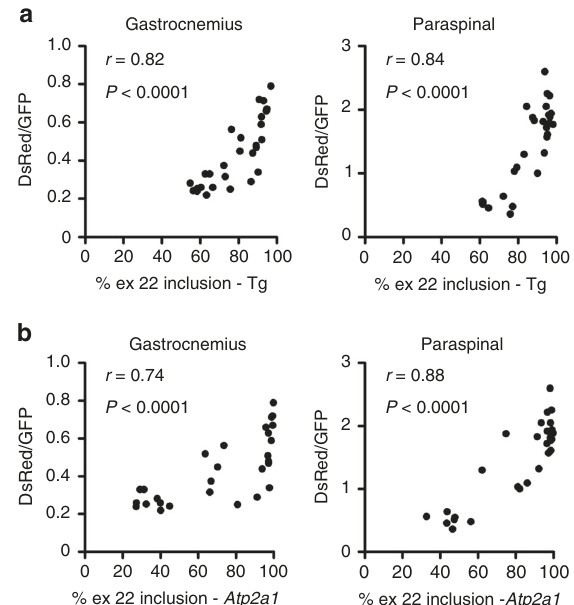
Fig. 8 Correlation of DsRed/GFP measurements with splicing in muscle tissue. We used fl uorescence spectroscopy to determine the DsRed/GFP in gastrocnemius and lumbar paraspinal muscles of TR;HSA LR bi-transgenic mice treated by subcutaneous injection of saline, unconjugated ASO, or LICA oligo ( N = 28) (see Figs. 6 and 7, and Supplementary Figs. 7 – 9). After the fi nal spectroscopy measurements at either Day 28 or 42, we dissected the gastrocnemius and lumbar paraspinal muscle tissues. To validate the spectroscopy measurements as estimations of alternative splicing in the entire muscle, we correlated fi nal DsRed/GFP measurements in gastrocnemius and lumbar paraspinal muscles with RT-PCR determination of exon 22 inclusion of a the ATP2A1 transgene (Tg) and b endogenous mouse Atp2a1 in these muscles. The correlation coef fi cient r and P value